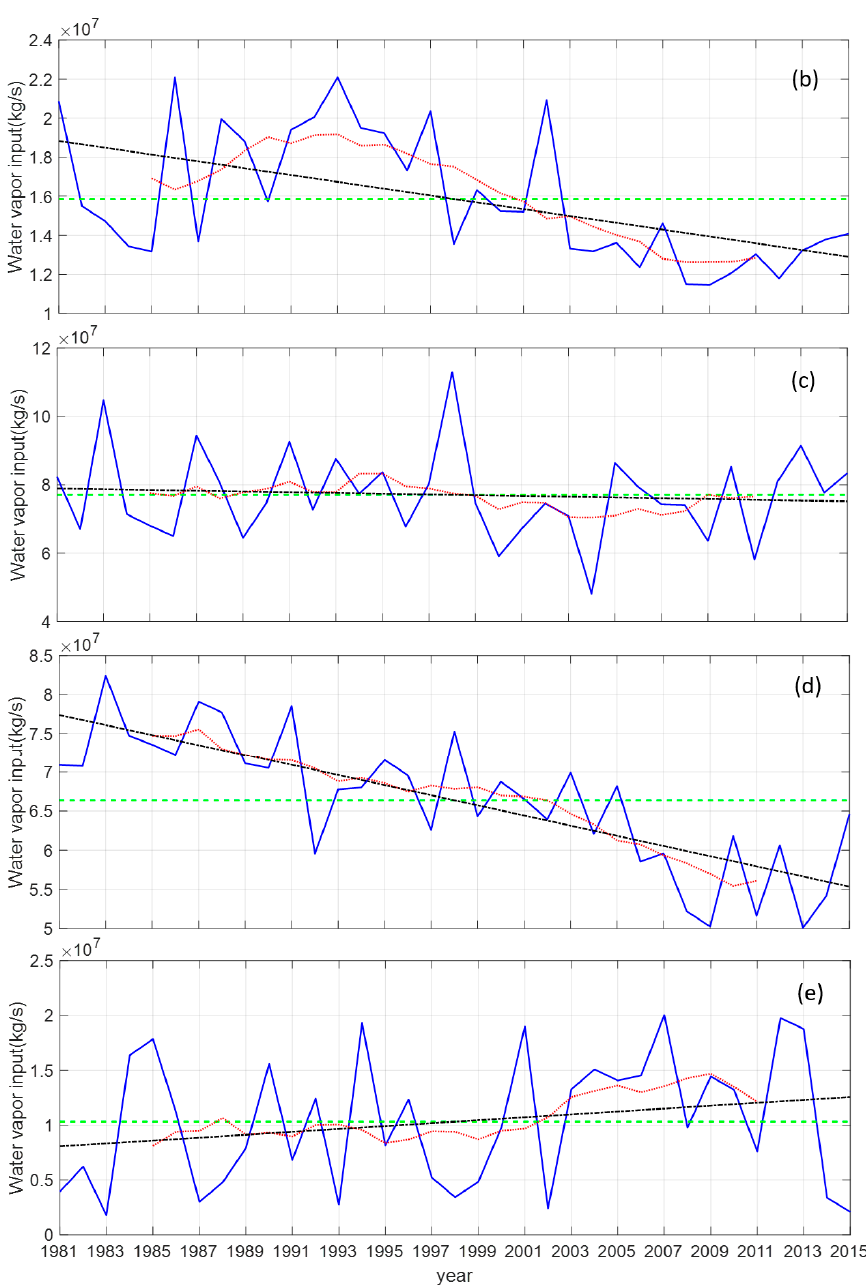
Figure 6. Total annual water vapor translated to the middle and lower reaches of the Yangtze River during 1981–2015 for the total area ( a ), northern boundary ( b ), southern boundary ( c ), western boundary ( d ) and eastern boundary ( e ). (Units: kg · s − 1 ) (Blue polyline). The green dotted line is the multi-year mean value, the black dotted line is the linear trend, and the red discount is the 9-year sliding mean